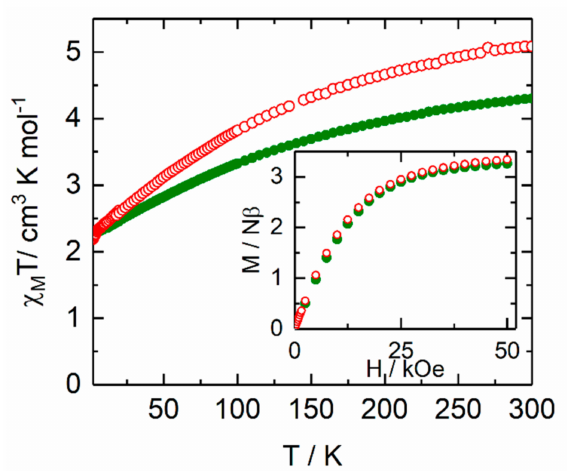
Figure 3. Temperature dependences of χ M T for H 2 SQ-Yb (green) and Q-Yb (red) in applied magnetic field of 10 kOe between 20 and 300 K while a magnetic field of only 2 kOe was used between 2 and 20 K. In inset, the field variations of the magnetization at 2 K for H 2 SQ-Yb (green) and Q-Yb (red) between 0 and 50